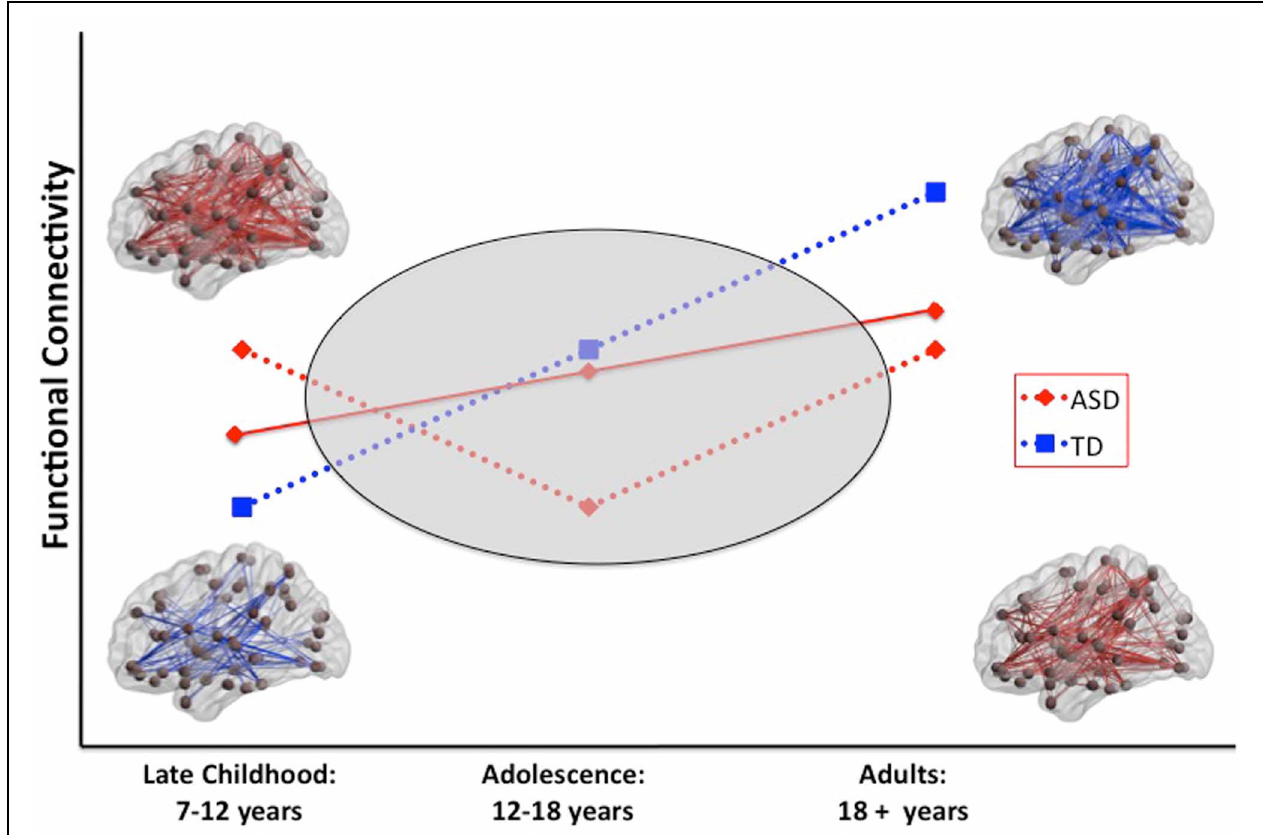
FIGURE 1 | Schematic model of two scenarios that could explain a developmental shift from intrinsic hyper-to hypo-connectivity in ASD. In scenario 1 (solid red line), the ASD group shows a less steep developmental increase in functional connectivity over the age span compared with the TD group. In scenario 2 (dashed red line), the ASD group shows anomalous patterns of connectivity across the pubertal